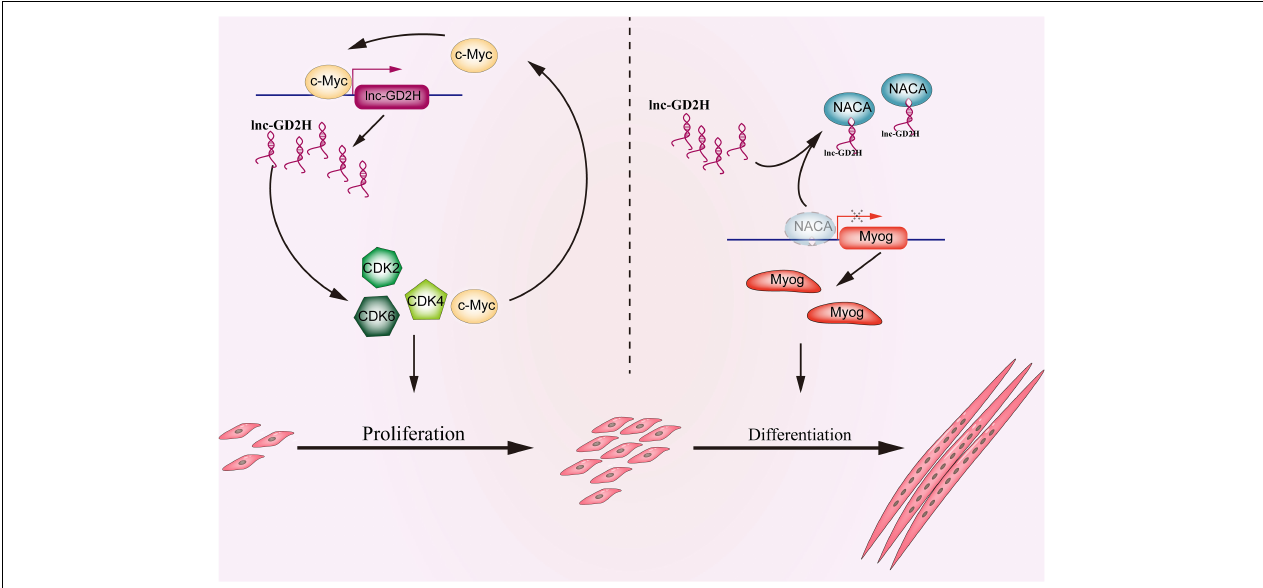
FIGURE 9 | Schematic depicting the functional roles of lnc-GD2H during myoblast proliferation and differentiation. In proliferating myoblasts, lnc-GD2H facilitates the expression of proliferating marker genes and forms a feedback loop with c-Myc. In differentiating myoblasts, lnc-GD2H binds to NACA to relieve the inhibitory effect of NACA on Myog to improve the Myog transcription and promote myoblast